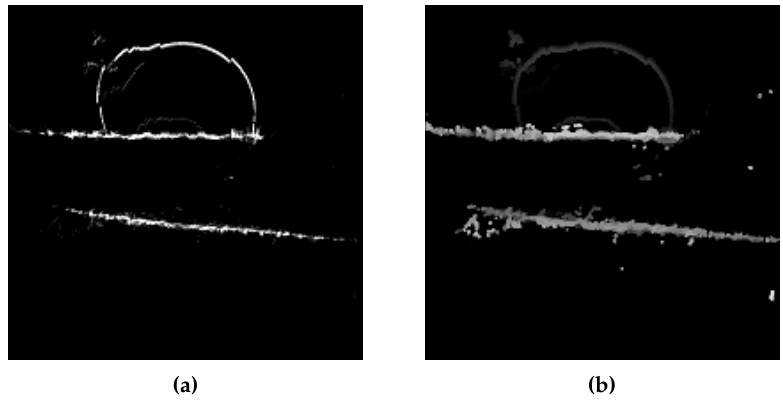
Figure 11. Ground imprints at the location Cap4/1560. Y axis is the bottom direction and X axis is the right direction. ( a ) XY histogram; ( b ) Heights